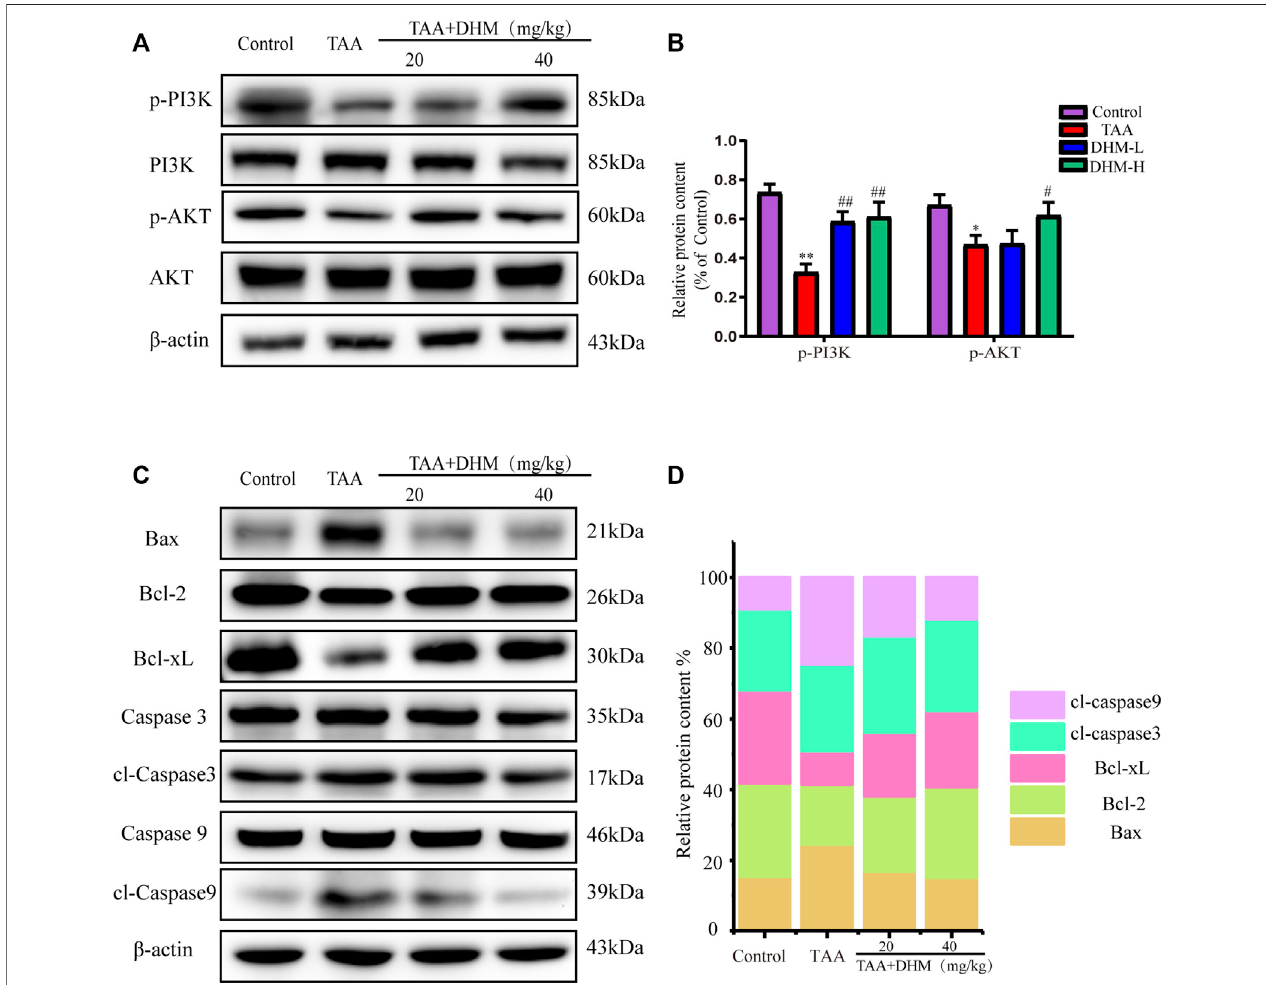
FIGURE5| DHMamelioratesPI3K/Akt-mediatedapoptosistoreverseTAA-induced hepatic fi brosis.Theproteinexpressionlevelsofp-PI3K,PI3K,AKT, p -AKTin liver tissues were examined by western blot. (A) and the protein expression levels of p-PI3K and p -AKT protein (B) ; The protein expression levels of Bax, Bcl-2, Bcl-xL, p -Caspase3,Caspase3, p -Caspase9,Caspase9inlivertissueswereexaminedbywesternblot (C) andtheproteinexpressionlevelsofBax,Bcl-2,Bcl-xL, p -Caspase 3 and p -Caspase 9 protein (D) ; β -actin protein was used as a loading control. Column charts showed relative expression levels of target protein, and protein expressionlevelswereperformedbyquanti fi cationofrelativeproteinexpressionanalysisineachgroup.Datawasexpressedasthemean ±